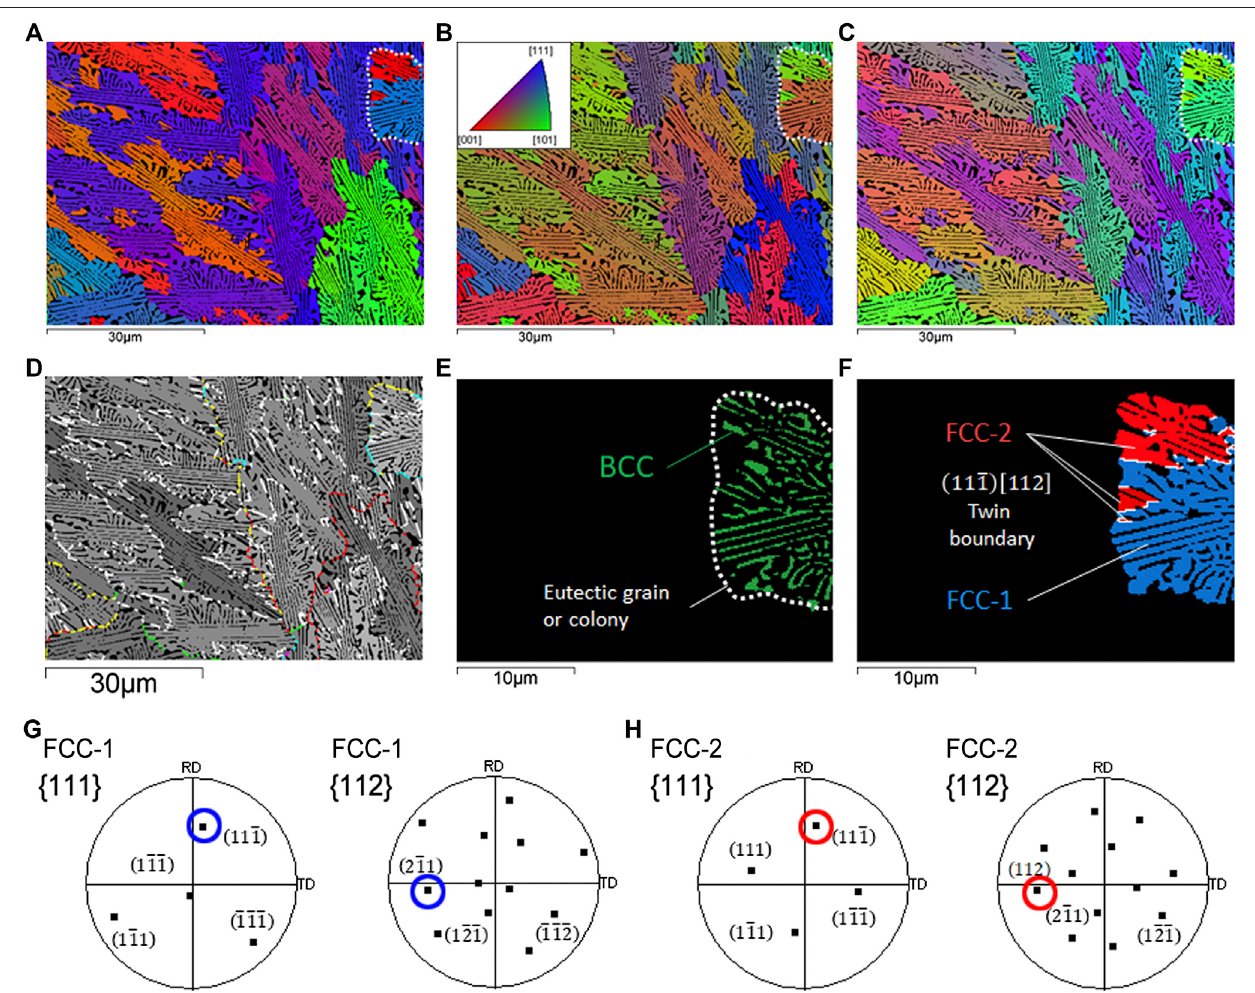
FIGURE 2 | FCC twins in the as-cast quinary eutectic alloy Ni 34.4 Fe 16.4 Co 16.4 Cr 16.4 Al 16.4 based on electron backscatter diffraction mapping results: (A – C) inverse pole fi gure coloring of the FCC orientation, (D) grain boundaries (colored lines) and twin boundaries (white lines) in the mapping region, (E, F) zoom-in view into one eutecticgrainwhichfeaturesasingleBCCorientationbuttwodistinctFCCorientationsseparatedby ( 111 )[ 112 ] twinboundaries, (G,H) pole fi guresfor{111}and{112} plane families corresponding to FCC-1 and FCC-2, respectively. The common planes/directions are marked with circles.